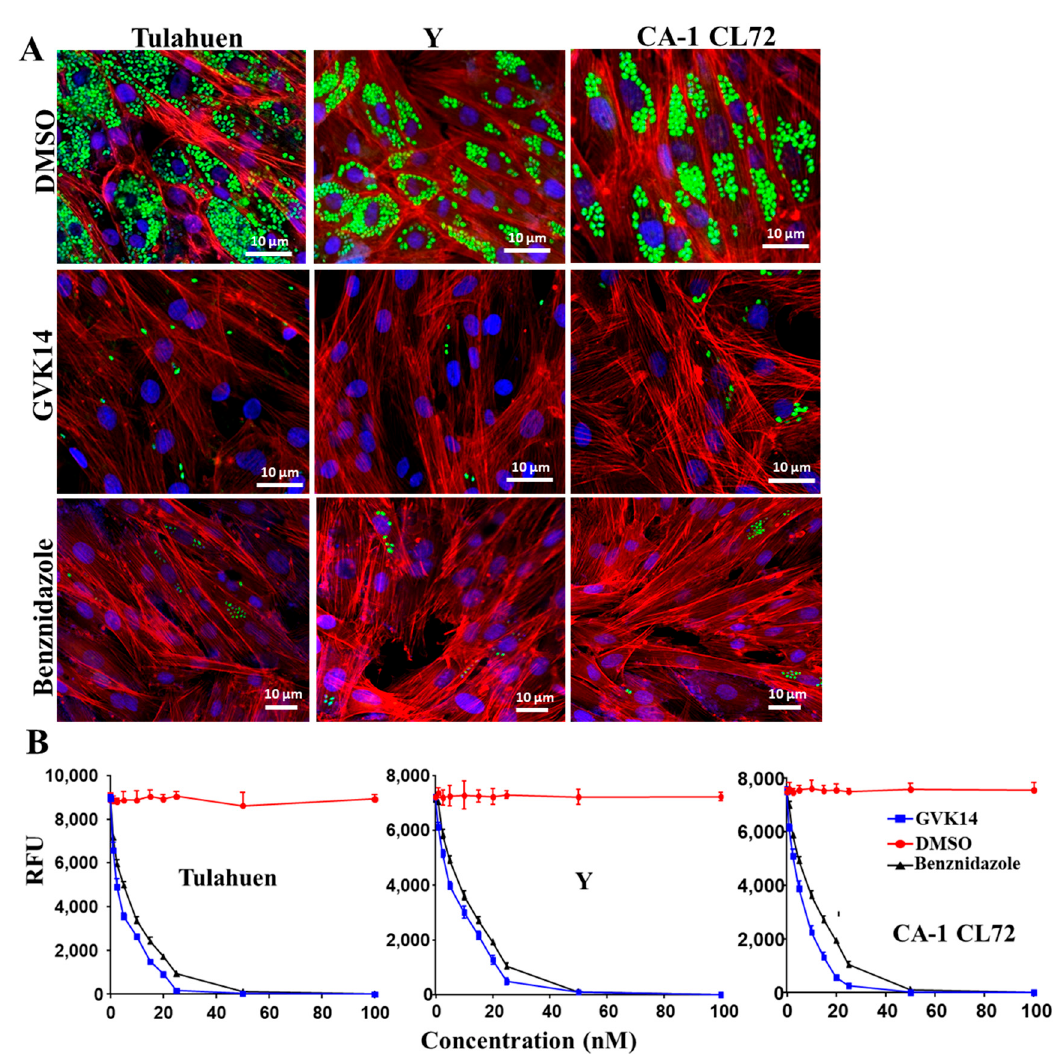
Figure 4. Effect of compounds on actively growing amastigotes in heart myoblasts infected with three T. cruzi strains. ( A ) RHM infected with GFP-expressing trypomastigote clones of Tulahuen, Y, and CA-1CL72 strains (infection of 10 parasites per cell) after 24 h of infection and then treated with GVK14 (50 nM) or, as positive control, benznidazole (50 nM) or DMSO. Green color represents T. cruzi amastigotes; blue represents cardiomyocyte nuclei; red is myoblast actin myofibrils. ( B ) Line graph depicting dose-dependent suppression of the Tulahuen, Y, and CA-1 CL72 strains expressed as relative fluorescence units (RFUs) at 72 h are shown. All experiments were performed in triplicate, and the results are presented as means ± SEs. Statistical analysis was performed by two-way ANOVA, p < 0.05.